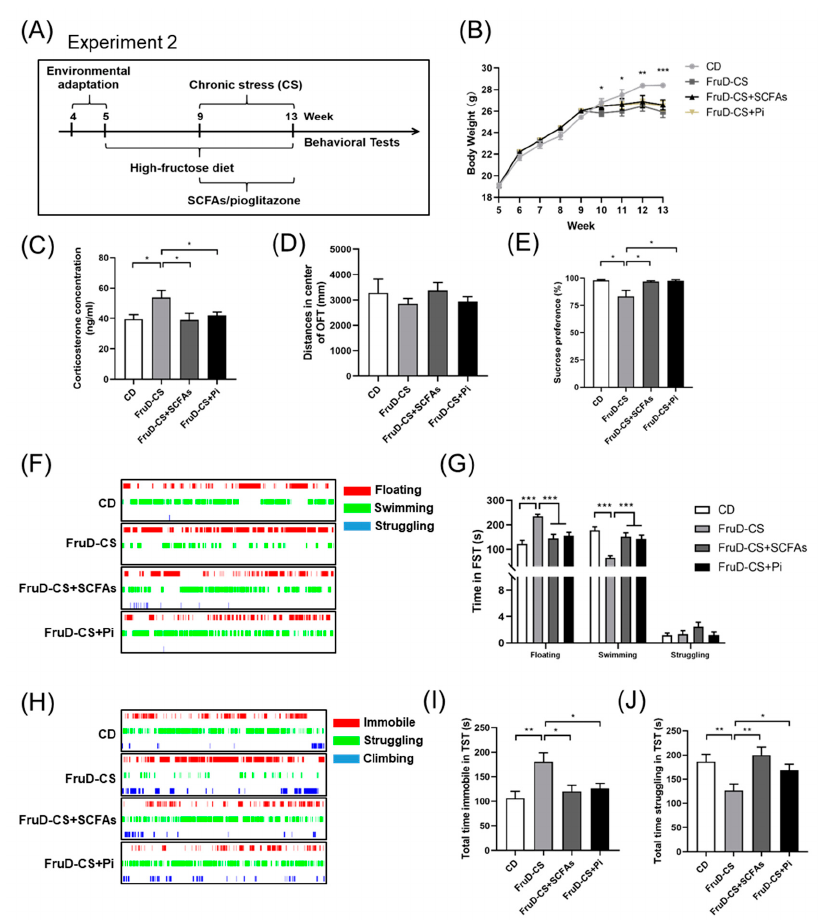
Figure 4. SCFAs and pioglitazone ameliorate depressive-like behaviors of FruD-CS mice. ( A ) Schematic diagram of mice dealing with SCFAs and pioglitazone treatment in FruD-CS mice. ( B ) Body weight of mice (* CD versus FruD-CS group). ( C ) Corticosterone level in serum of mice. ( D – J ) Behavioral test and representative state images of mice in OFT ( D ), SPT ( E ), FST ( F , G ) and TST ( H – J ). Data are expressed as mean ± SEM, * p < 0.05, ** p < 0.01, *** p < 0.01.